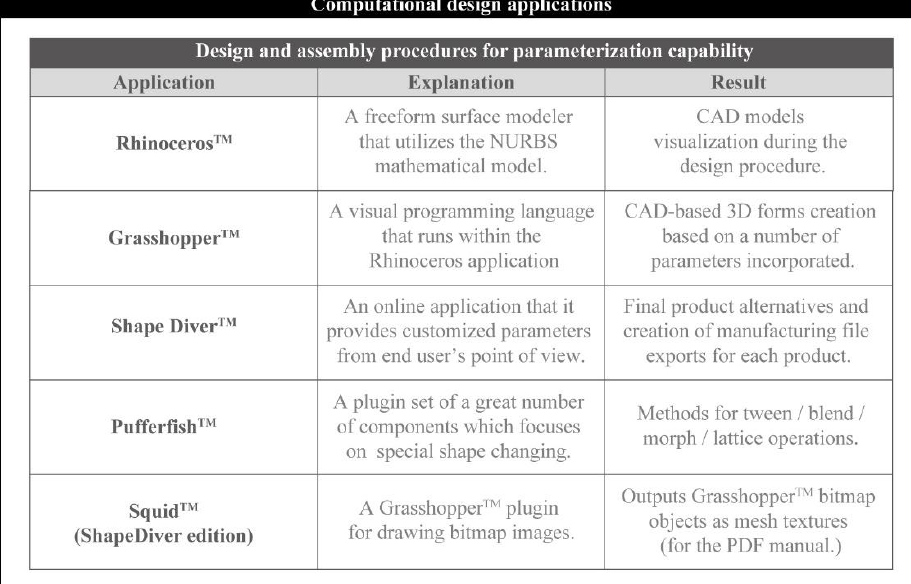
Figure 10. Implementation tools based on computational design